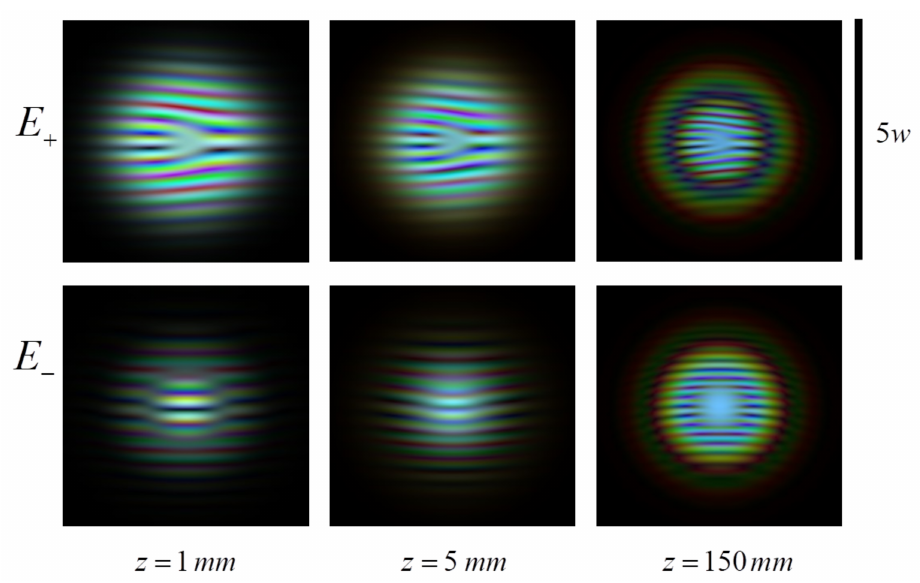
Figure 6. Interference of circular components of a polychromatic Laguerre–Gauss beam with n = 0, l = 2 and w 0 = 20 mkm.